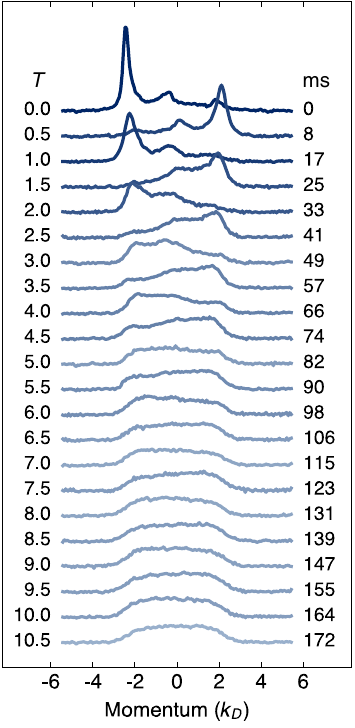
FIG. 14. Time evolution of an initially single-sided momentum distribution, whose dephasing timescale accounts for the tech- nical dephasing mechanisms while minimizing those from high- energy collisions.